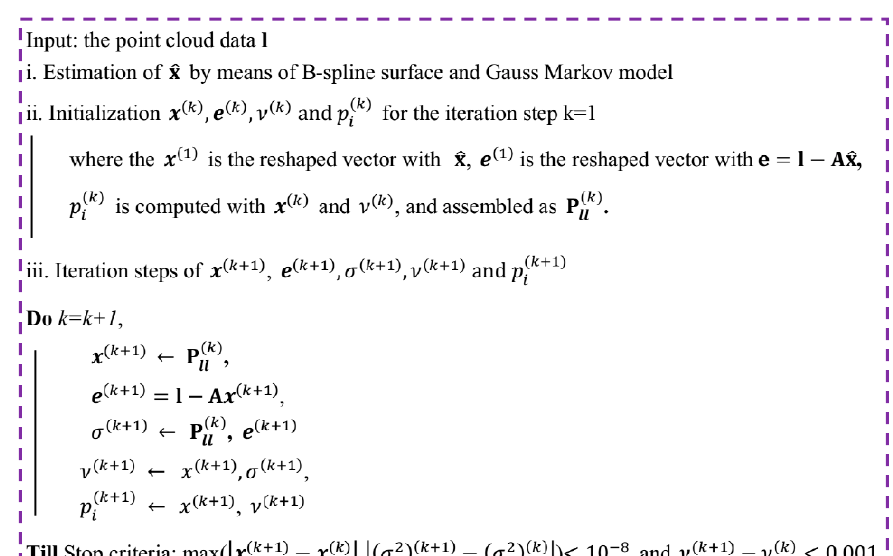
Figure 3. The IRLS algorithm for robust B-spline modelling.